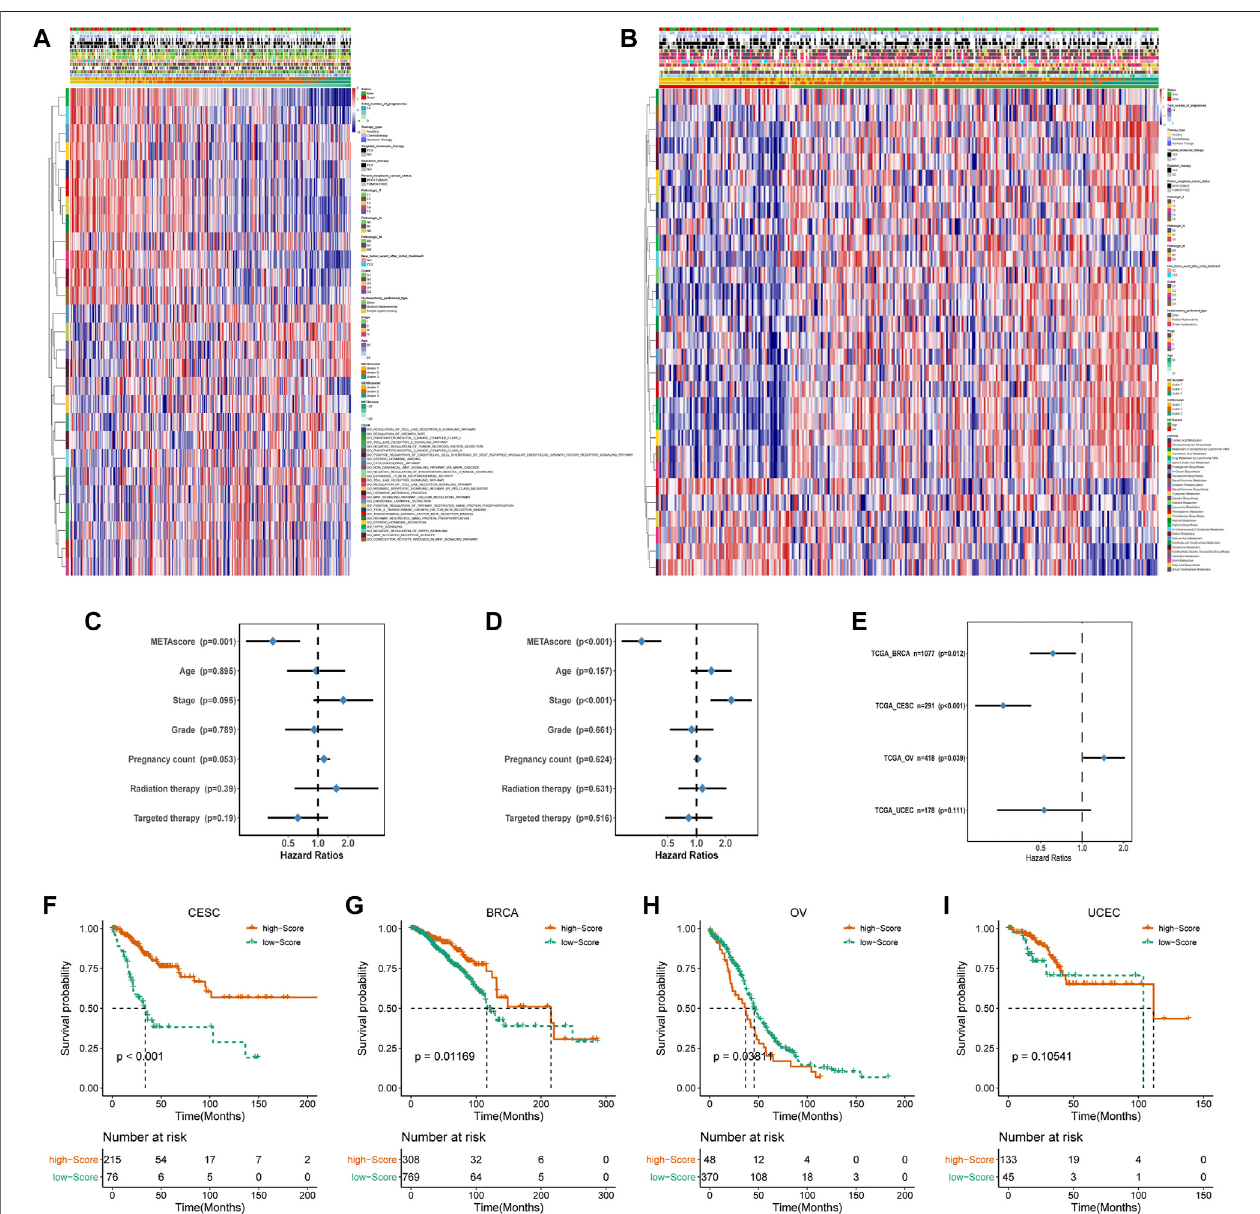
FIGURE 5 | Construction of METAscore and functional annotation. (A) Pathway enrichment analysis showing the differential activated transcriptome pathways relatedtoMETAscore. (B) PathwayenrichmentanalysisshowingthedifferentialactivatedmetabolicpathwaysrelatedtoMETAscore.Heatmapswereplottedtovisualize the biological processes. (C – D) Hazard ratios (HR) of METAscore in multivariate (C) and univariate (D) cox regression models combined with CESC patient clinical characteristics. (E) Hazardratios(HR)ofMETAscoreestimatingtheprognosticvalueindifferentgynecologiccancers.Thehorizontallinelengthrepresentsthe95% con fi denceintervalforeachcancertype.TheverticallinerepresentsHR (cid:1) 1. (F-I) Kaplan – Meiercurvesforsurvivalofthehigh-andlow-METAscoregroupsinCESC( (F) , p < 0.001, log-rank test), BRCA ( (G) , p (cid:1) 0.01169, log-rank test), OV ( (H) , p (cid:1) 0.03811, log-rank test). and UCEC ( (I) , p (cid:1) 0.10541, log-rank test).